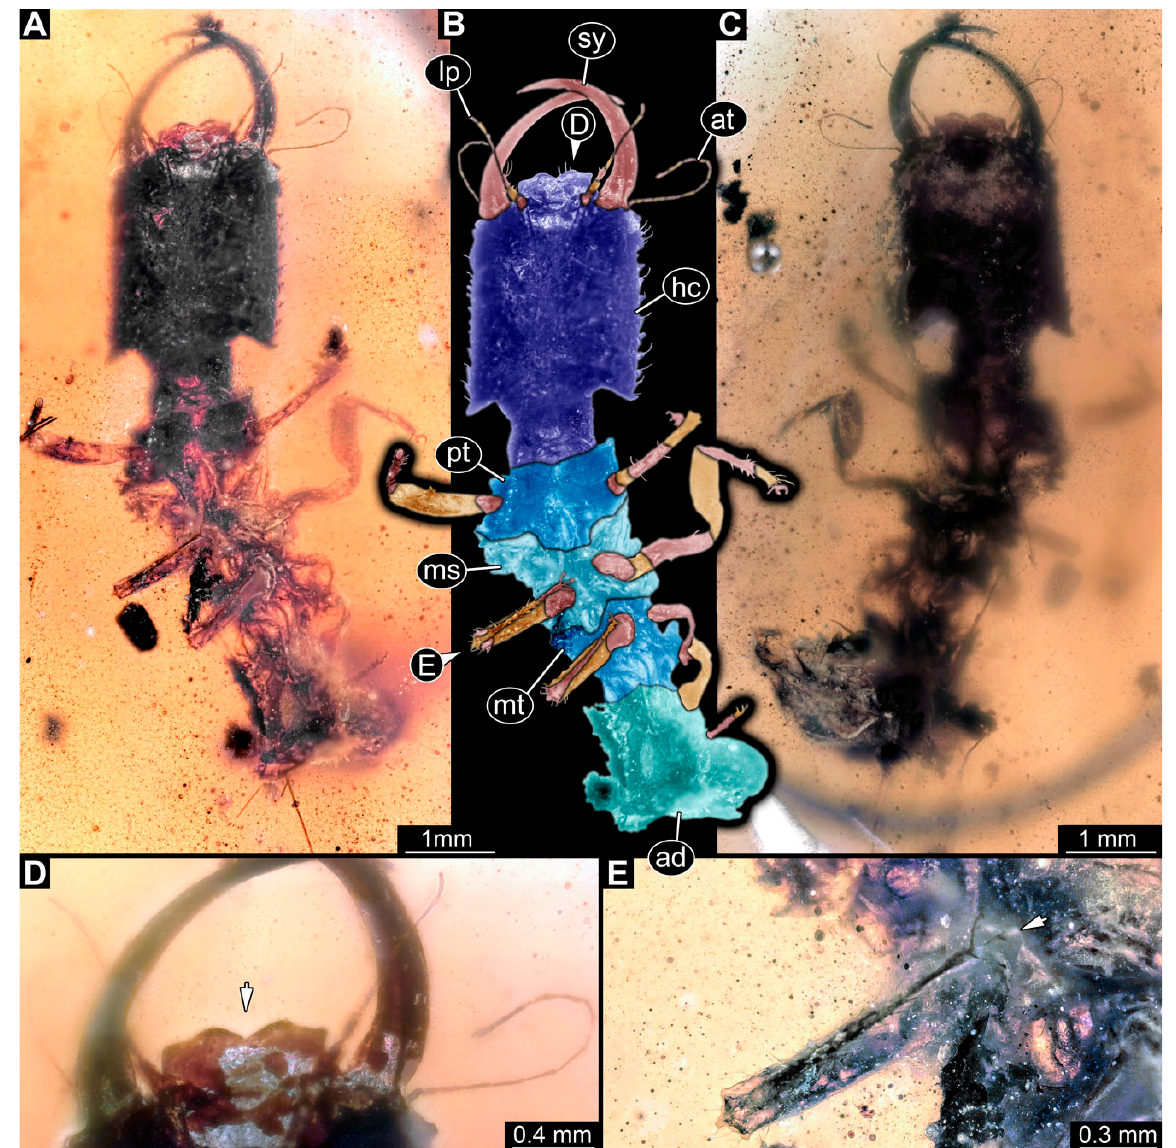
Figure 18. Specimen 79 (PED 1726); Myanmar amber. ( A ) Ventral view. ( B ) Ventral view, colour- marked. ( C ) Dorsal view. ( D ) Close-up of labrum in ventral view; arrow marks a broad cleft in the labrum. ( E ) Close-up of second locomotory appendage; arrow marks empodium. Abbreviations: ad = abdomen; at = antenna; hc = head capsule; lp = labial palp; ms = mesothorax; mt = metathorax; pt = prothorax; sy = stylet.